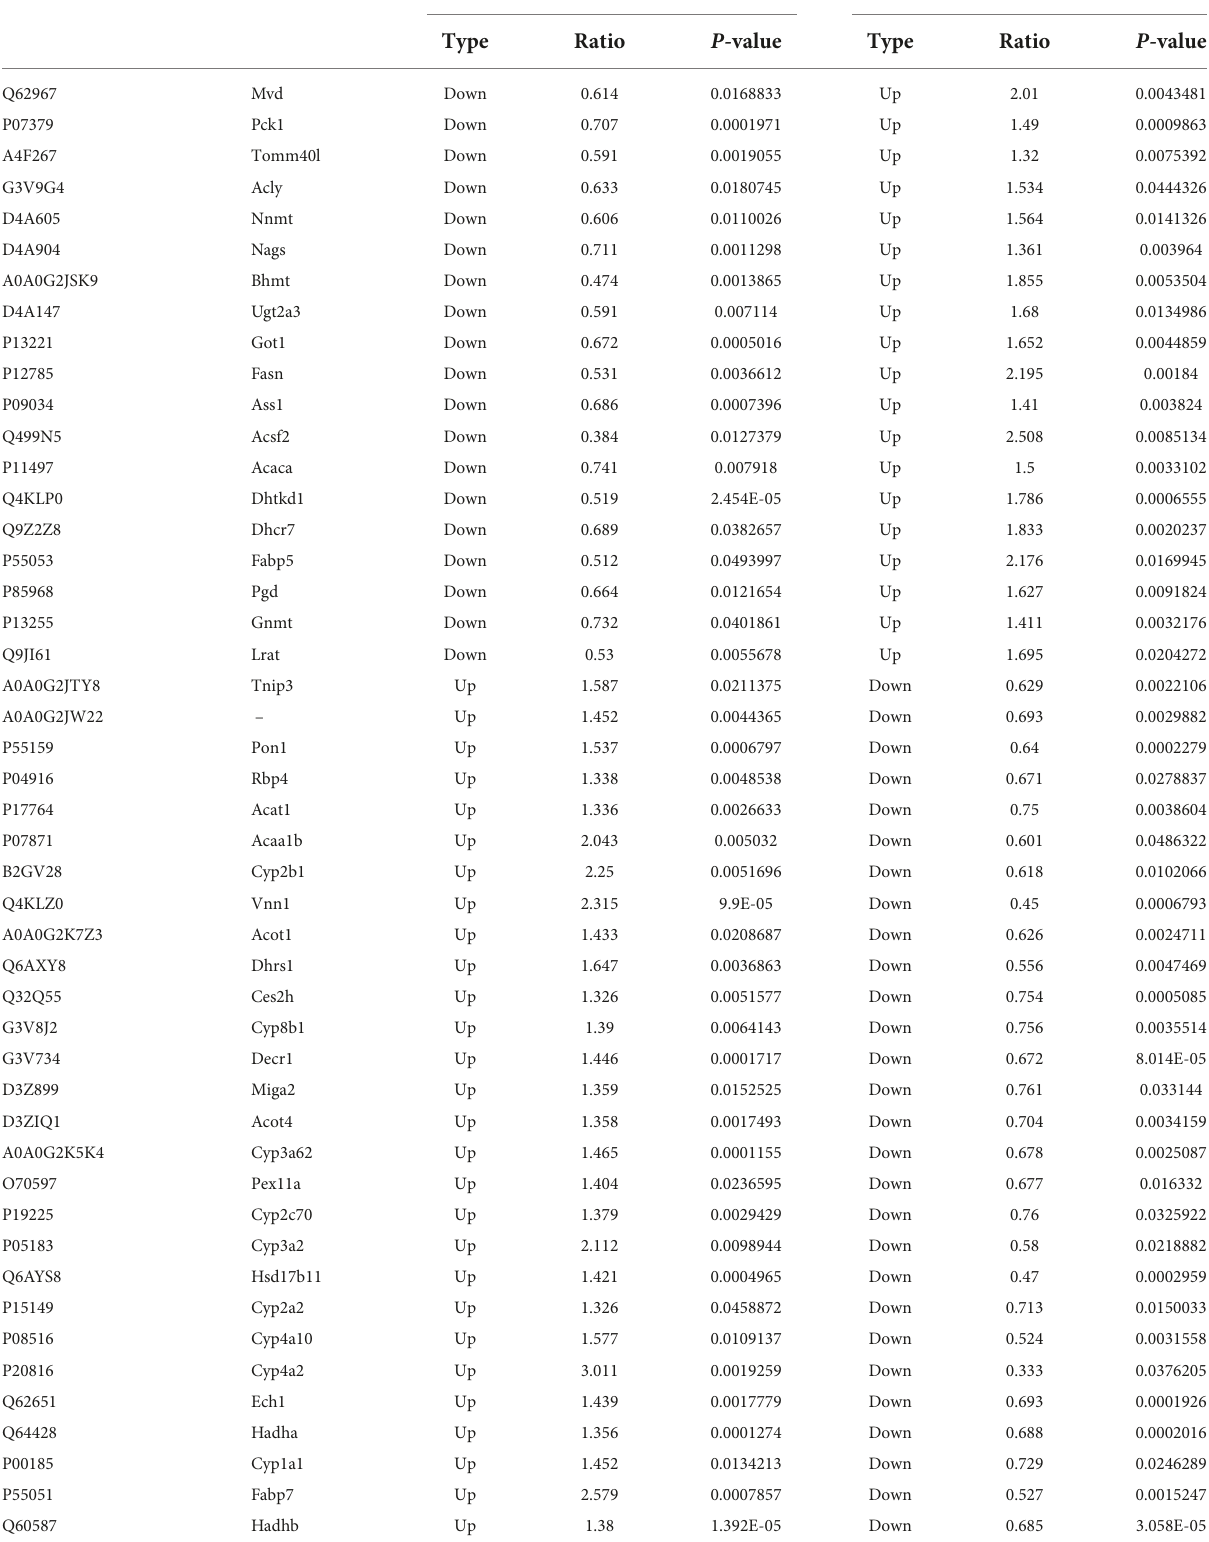
TABLE 1 Fifty-two differentially expressed proteins (DEPs) common to three groups (ND, HFD, HFDS). Protein